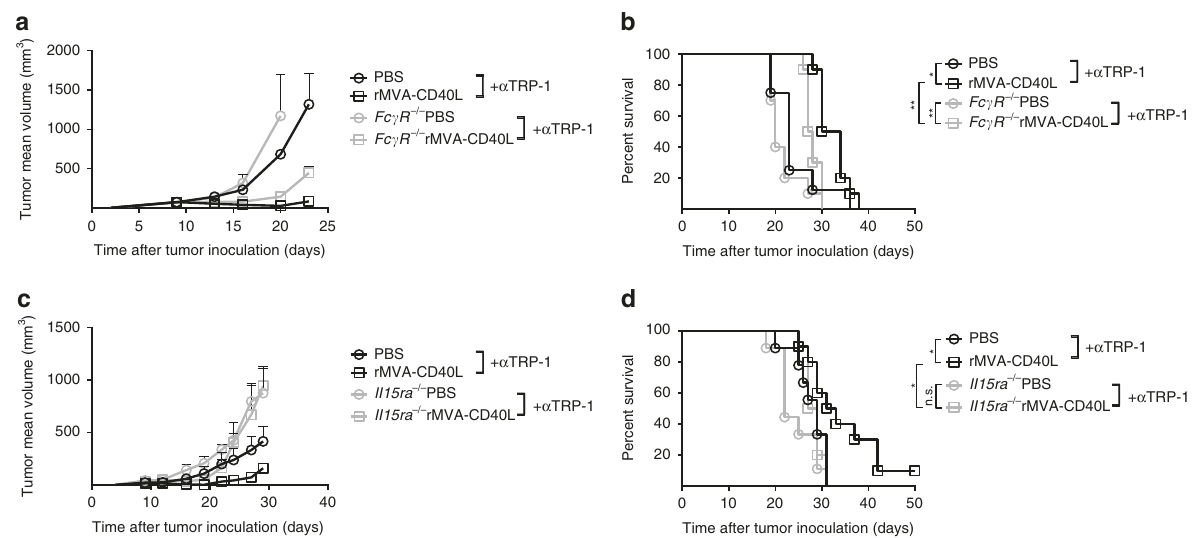
Fig. 6 rMVA-CD40L/TAA mAb combination is dependent on Fc γ receptors and NK cells. a , b B16.OVA tumor-bearing wild-type and Fc γ R − / − mice were grouped according to tumor size. Tumor-bearing littermates either received PBS or were immunized with 5 × 10 7 TCID 50 of rMVA-CD40L (Day 0). Mice received 200 µ g of anti-TRP-1 antibody i.p. at days − 2, 2, 6, and 10. a Tumor size follow-up ( n = 5 mice/group) and b overall survival ( n = 10 mice/group). c , d B16.OVA tumor-bearing wild-type and Il15ra − / − mice were grouped according to tumor size. Tumor-bearing mice either received PBS or were immunized with 5 × 10 7 TCID 50 of rMVA-CD40L (Day 0). Mice received 200 µ g of anti-TRP-1 antibody i.p. at days − 2, 2, 6, and 10. c Tumor size follow-up ( n = 5 mice/group) and d overall survival ( n = 10 mice/group). b , d Overall survival of two merged independent experiments. Data in a and c are expressed as mean ± SEM. One-way ANOVA was performed on a and c . Log-rank test on mouse survival was performed for b and d . * p < 0.05; ** p <